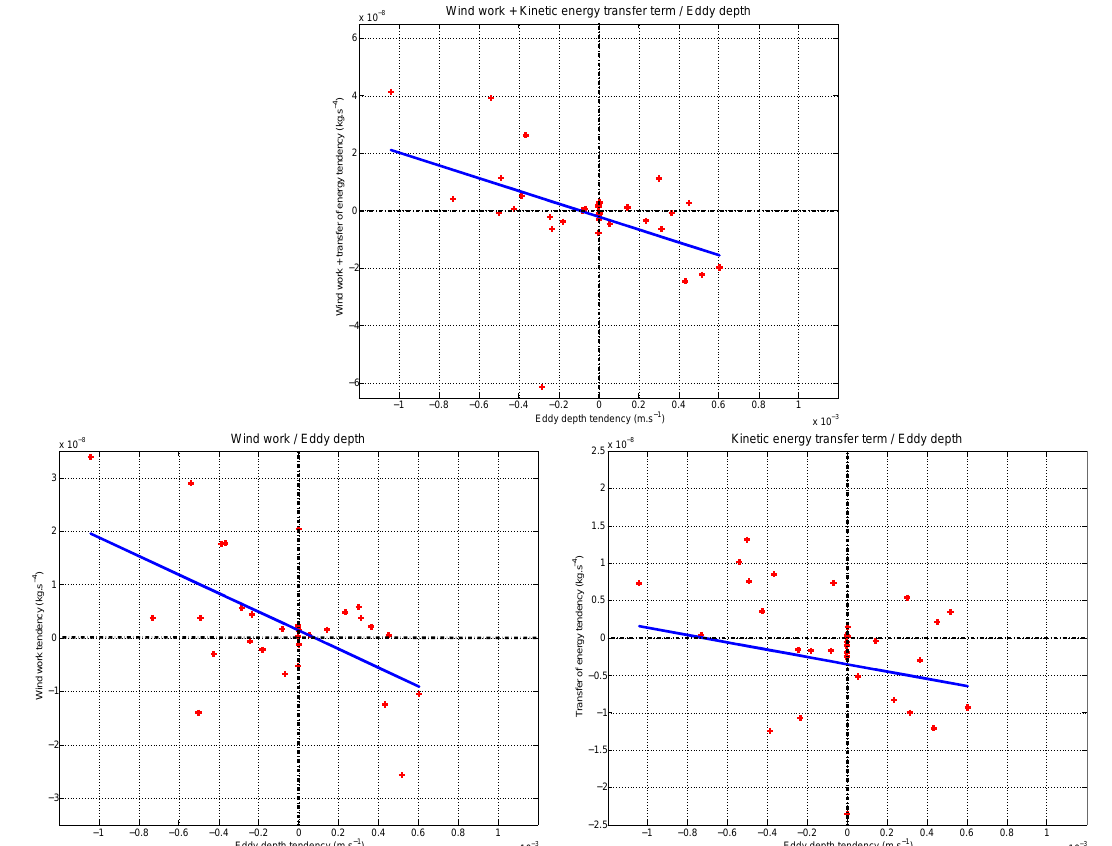
Figure 16. Comparison of the tendencies of transfer terms (energy and wind work) with the tendency of the eddies’ depth. Five different stationary eddies were studied in the HYCOM simulation. The parameters are the wind work P down (bottom, left), the transfer term from the baroclinic energy to barotropic due to vorticity (cid:8) K (cid:48) ¯ K (cid:9) (bottom, right), and the sum of those two ξ